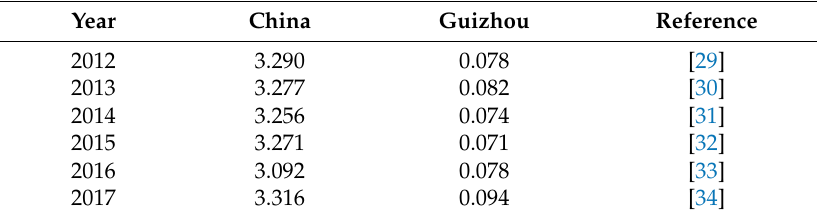
Table 2. Generation of general industrial solid waste during 2012–2017, in Guizhou, China (unit: billion